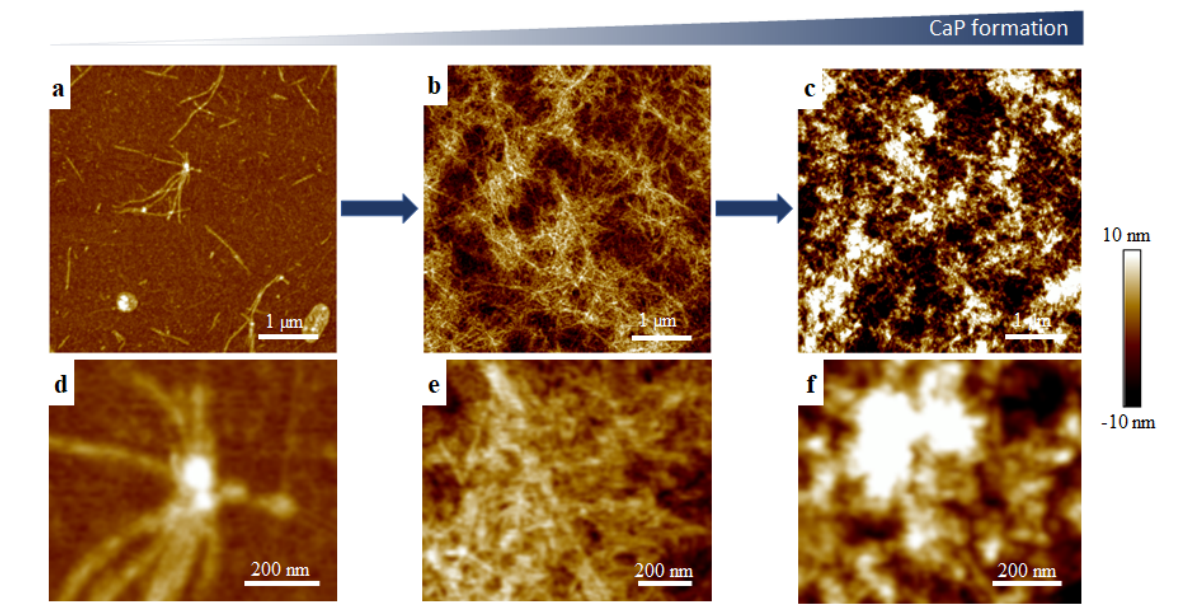
Figure 1. Tapping mode AFM in ambient conditions of amelotin self-assembly in calcium phosphate solutions after ( a , d ) 7, ( b , e ) 21 and ( c , f ) 28 days post initial assembly and incubation at 37 °C.